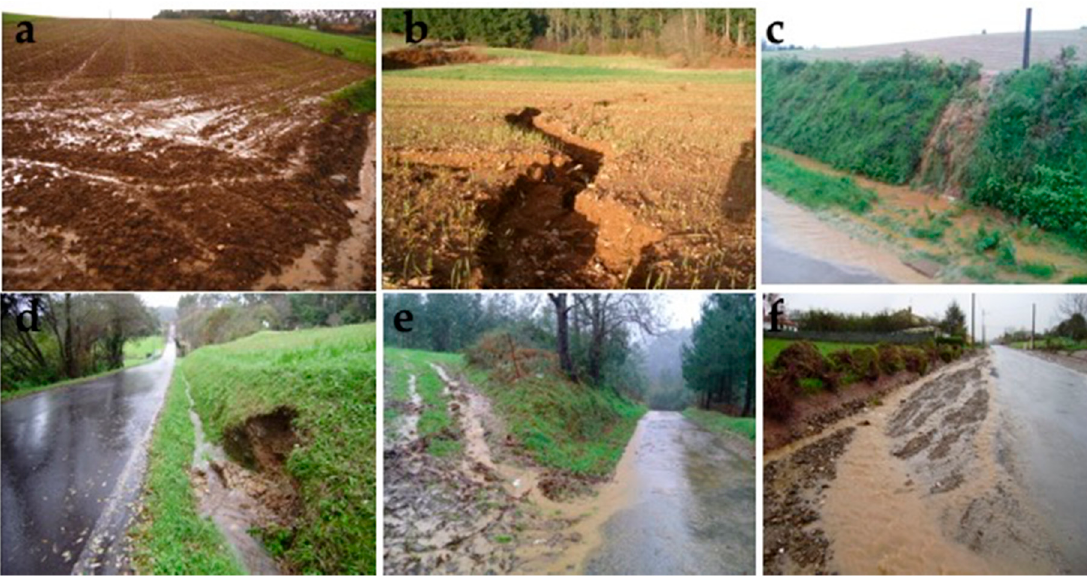
Figure 7. Some sediment sources in the Corbeira catchment during the study period. ( a ) Interrill erosion in cultivated soils; ( b , c ) rill and ephemeral gullies in cultivated soils; ( d ) small landslide near the catchment outlet; ( e , f ) soil erosion in road infrastructures.